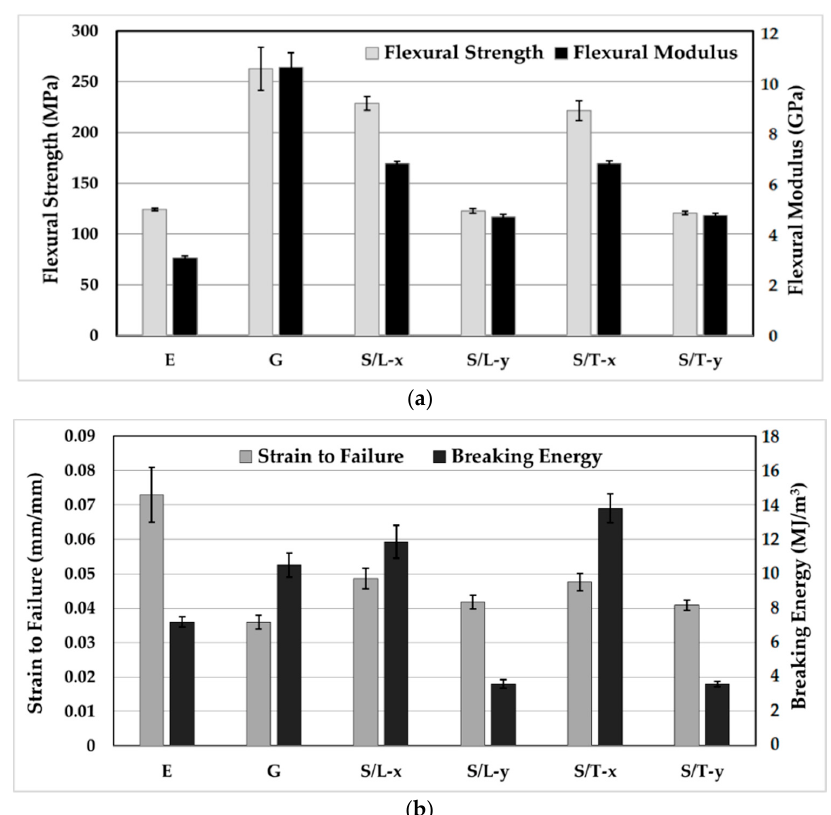
Figure 6. Flexural properties of silk/epoxy composite laminates in comparison with neat epoxy and glass/epoxy laminates [43]: ( a ) Flexural strength and modulus and ( b ) strain to failure and breaking energy.